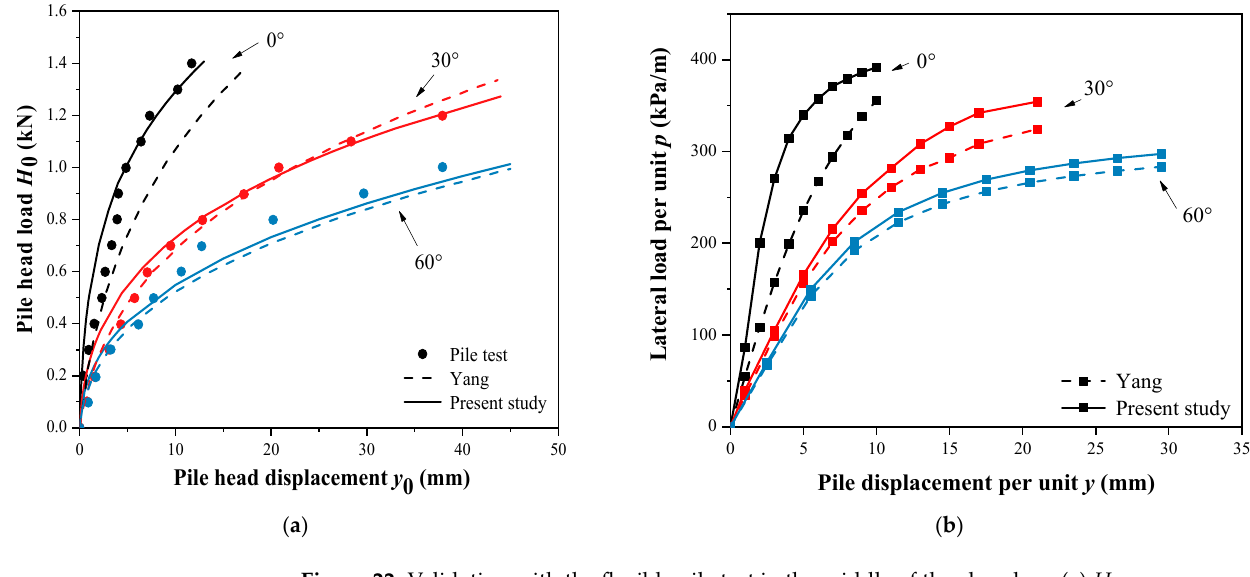
Figure 22. Validation with the flexible pile test in the middle of the clay slope.( a ) H 0 − y 0 curves and ( b ) 𝑝 − 𝑦 curves at depth of z = 0 m [16].